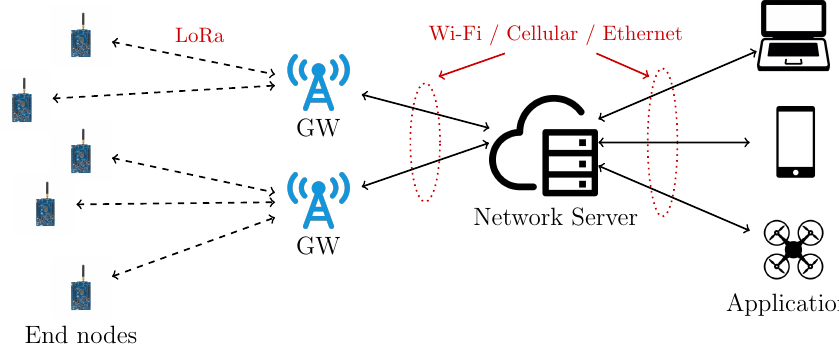
Figure 1. LoRaWAN